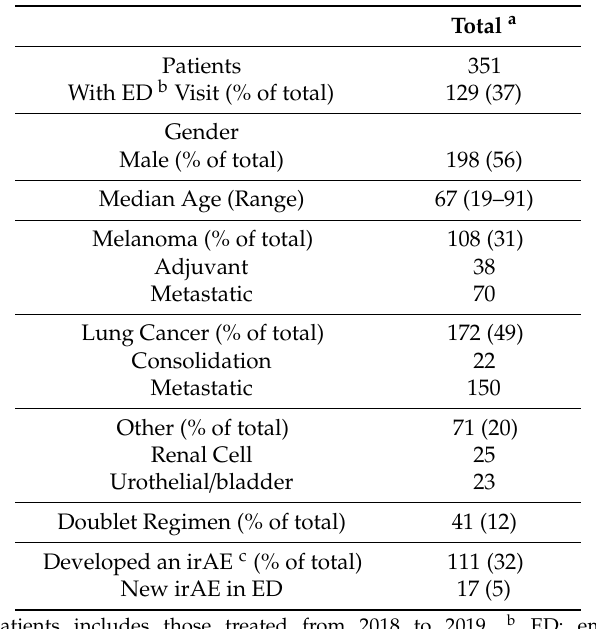
Table 1. Characteristics of patients receiving immune checkpoint